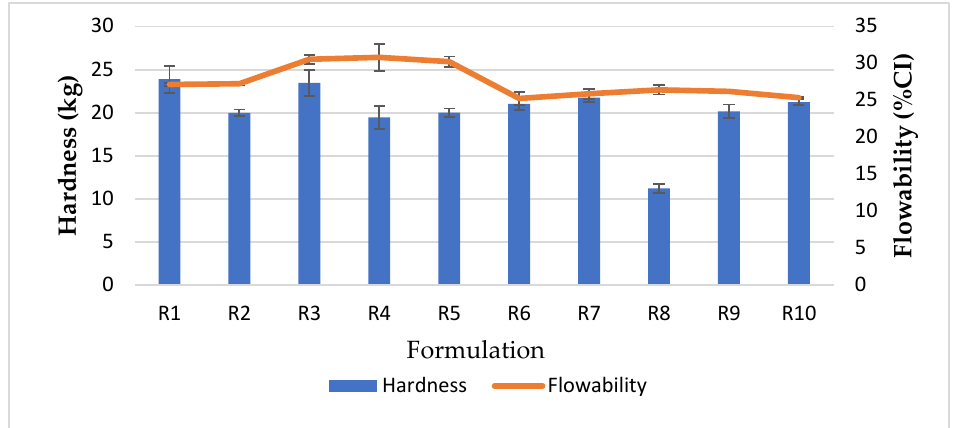
Figure 1. Tablet hardness versus flow properties of CCK.